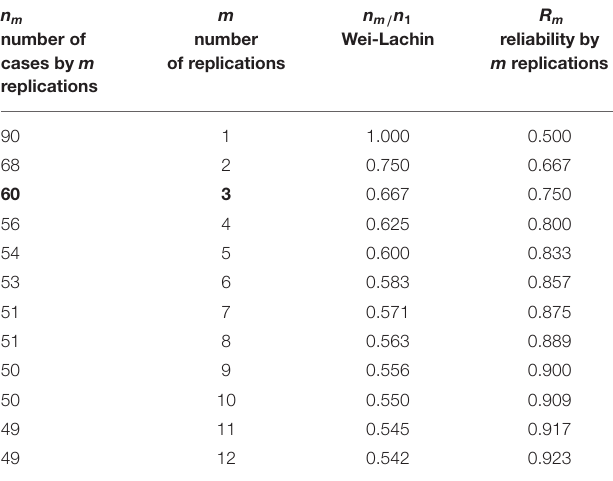
TABLE 3 | Precision of a study depending on the number of replications of measurement; for the value ̺ = R = 0.5, sample size according to the Wei-Lachin procedure, and